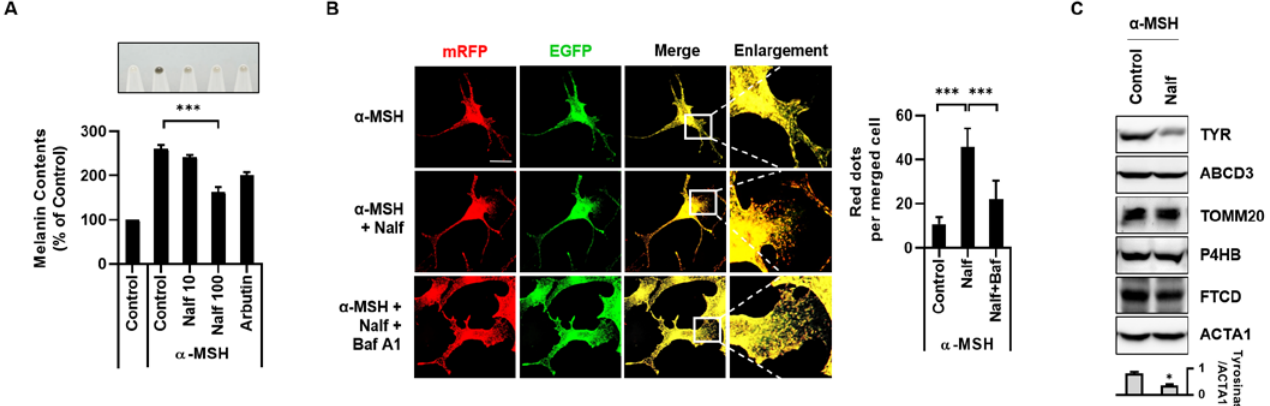
Figure 2. Nalfurafine hydrochloride decreases melanin content by enhancing the degradation of melanosomes in α -MSH-treated B16F1 cells. ( A ) B16F1 cells pre-treated with α -MSH for 48 h were further exposed to nalfurafine hydrochloride (Nalf, 10, 100 μM) or Arbutin (500 μM) for an additional 24 h. Subsequently, the cells were harvested (cell pellets: upper panel), and melanin content was measured as described in the Materials and Methods. ( B ) B16F1/TPC2-mRFP-EGFP cells were pre- treated with α -MSH (0.5 μM) for 48 h and then further incubated with nalfurafine hydrochloride (Nalf, 100 μM) with or without bafilomycin A1 (Baf A1, 100 nM) for 24 h. The cells were fixed, and the distribution of TPC2-mRFP-EGFP was imaged with confocal microscopy. The number of RFP-only puncta per cells was quantified from merged images. ( C ) B16F1 cells were pre-treated with α -MSH (0.5 μM) for 48 h and then further incubated with nalfurafine hydrochloride (Nalf, 100 μM). Cells were harvested and analyzed by Western blotting with the indicated antibodies (TYR: tyrosinase (melanosome), ABCD3 (peroxisome), TOMM20 (mitochondria), P4HB (endoplasmic reticulum), FTCD (Golgi). Additionally, the protein levels were measured by densitometry analysis. (n = 3, * p < 0.05, *** p < 0.001.) The scale bar indicates 10 μm.